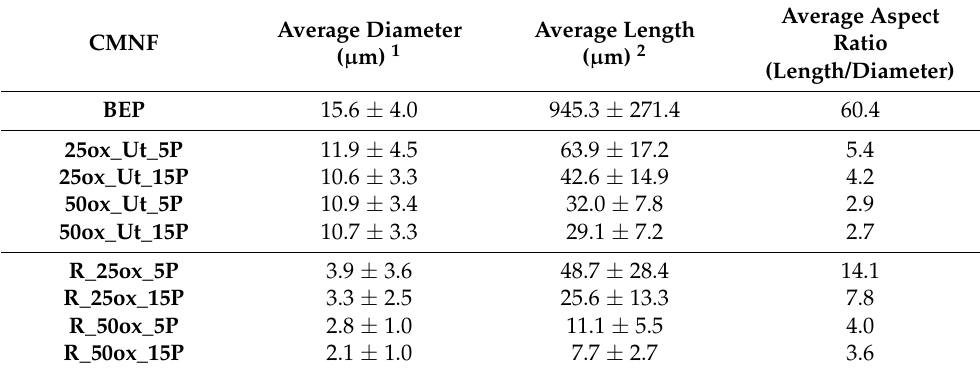
Table 3. Average diameter, length and aspect ratio of original pulp and CMNF fraction of a diameter greater than 1.0 µ m determined by optical